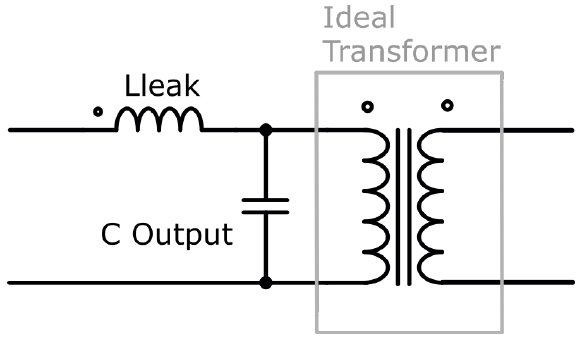
Figure 3. Step up of the transformer equivalent